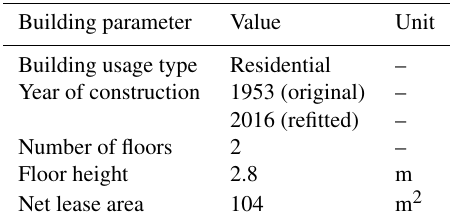
Table 1. Building parameters used as simulation input for